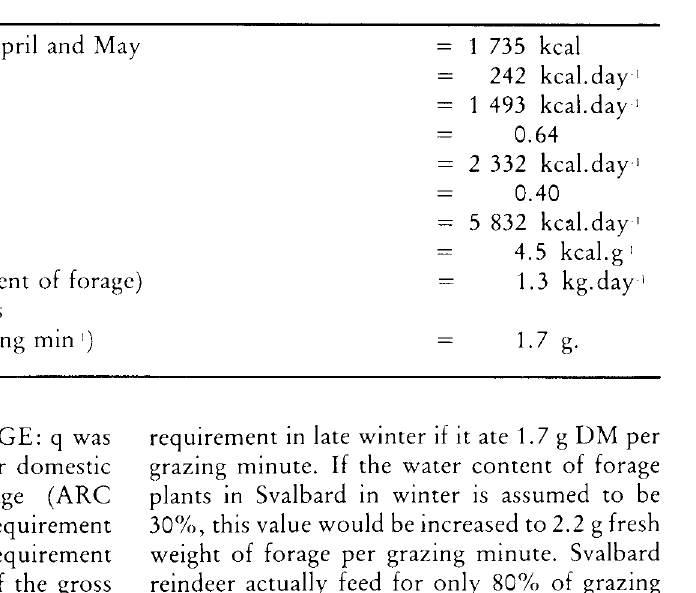
Tabic 1. Example calculation for estimating the daily dry matter requirement of a non-pregnant adult female Svalbard reindeer in late winter.